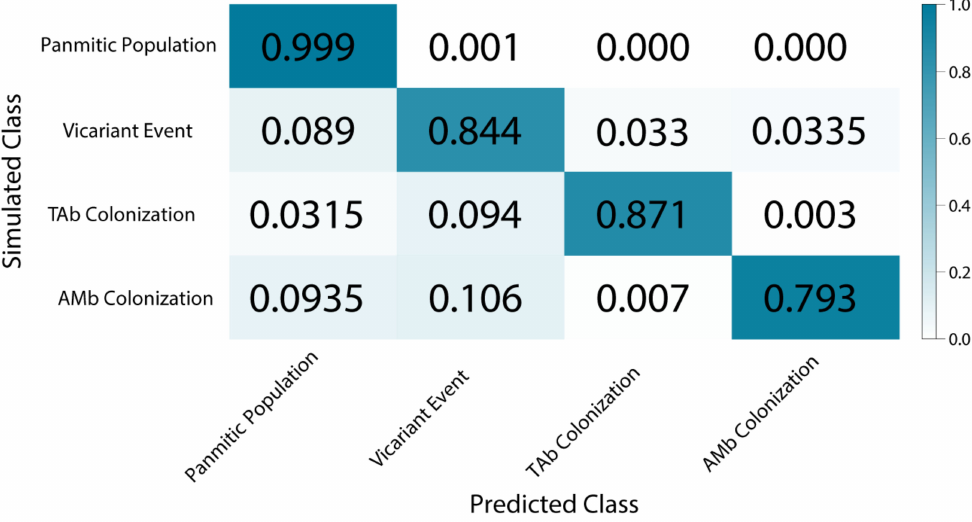
Figure 6. Confusion matrix of deep learning model selection accuracy in predicting correct classes. Diagonal line evidences correct predictions, o ff -diagonal rectangles, show incorrect predictions. The intensity of blue color and values indicates the